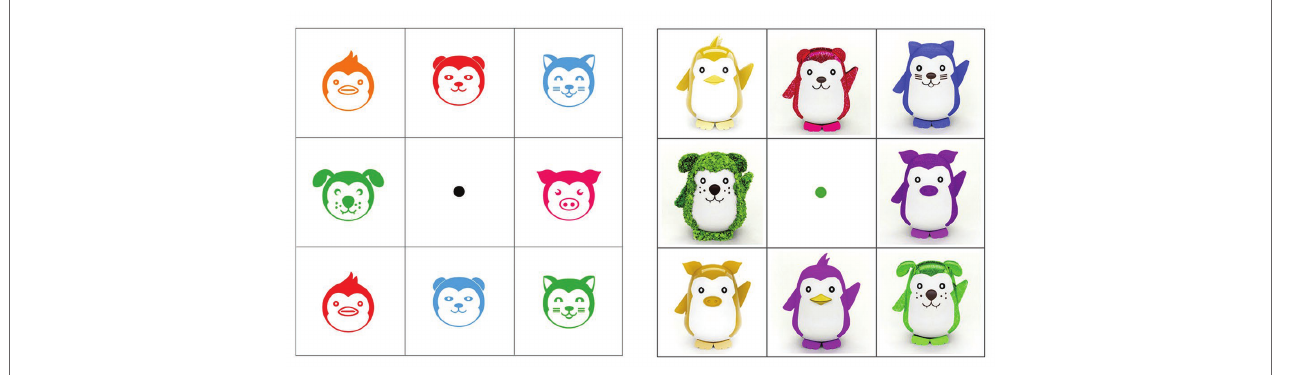
FIGURE 3 | Stimulus layout from the eight-alternative forced-choice (8-AFC) task for icons version (left) and toys version (right).